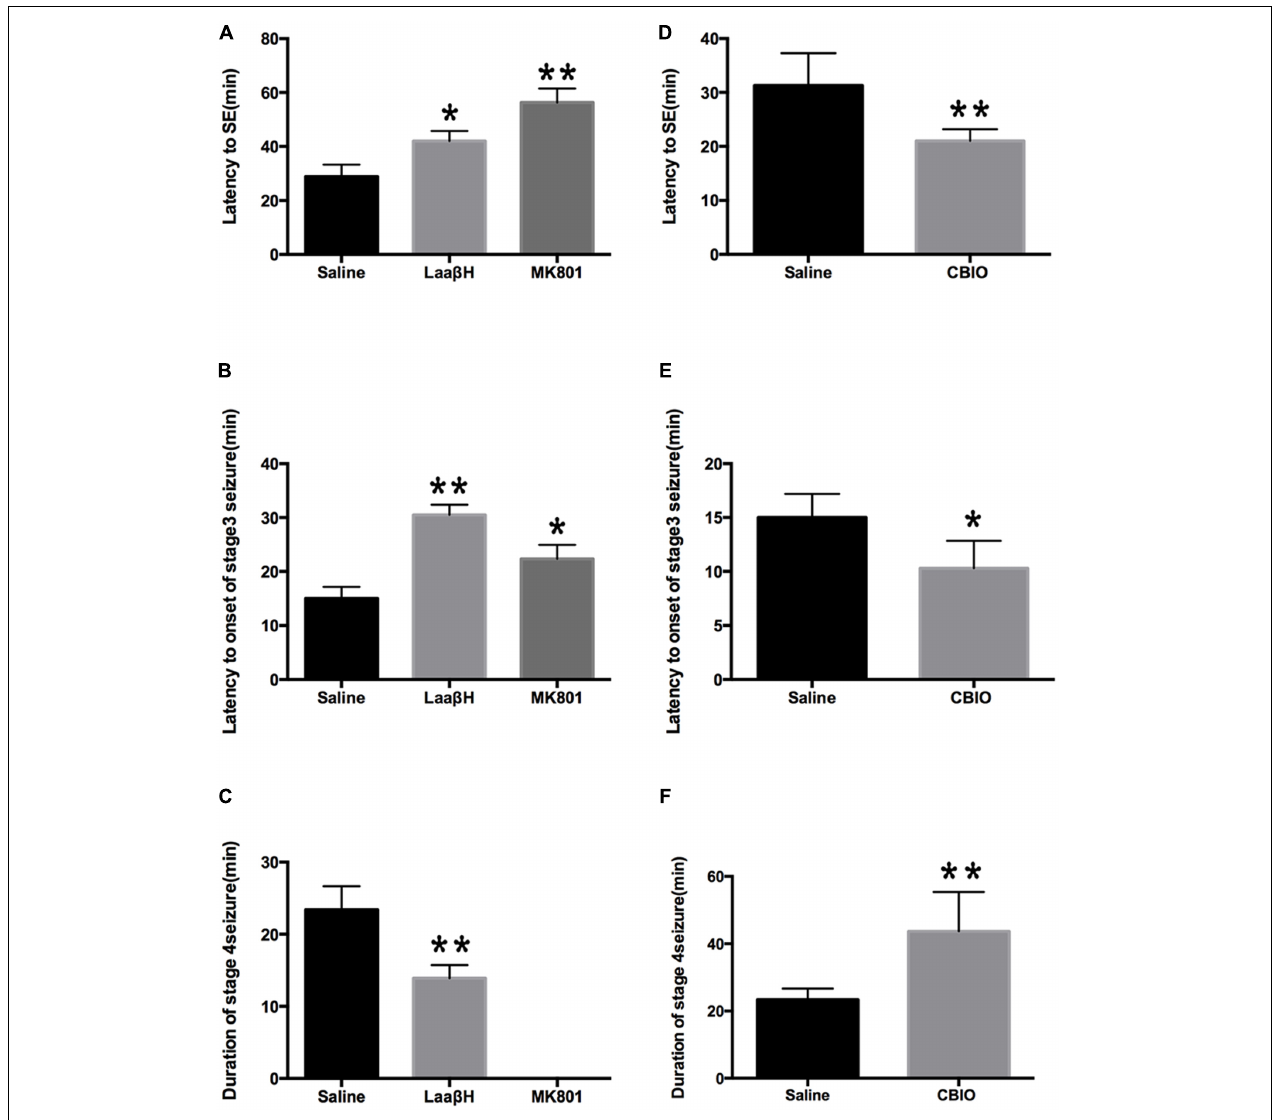
FIGURE 4 | Effects of MK801, Laa β H and CBIO on the on the development of seizures. (A,B) Effects of Laa β H and MK801 on the latency to stage 3 seizures. (C) Effects of Laa β H and MK801 on the duration of stage 4 seizures. (D,E) Effects of CBIO on the latency to stage 3 seizures. (F) Effects of CBIO on the duration of stage 4 seizures. N = 5 rats per group. Laa β H could significantly inhibit the development of seizures, while CBIO could significantly stimulate the development of seizures. ∗ P < 0.05, ∗∗ P <